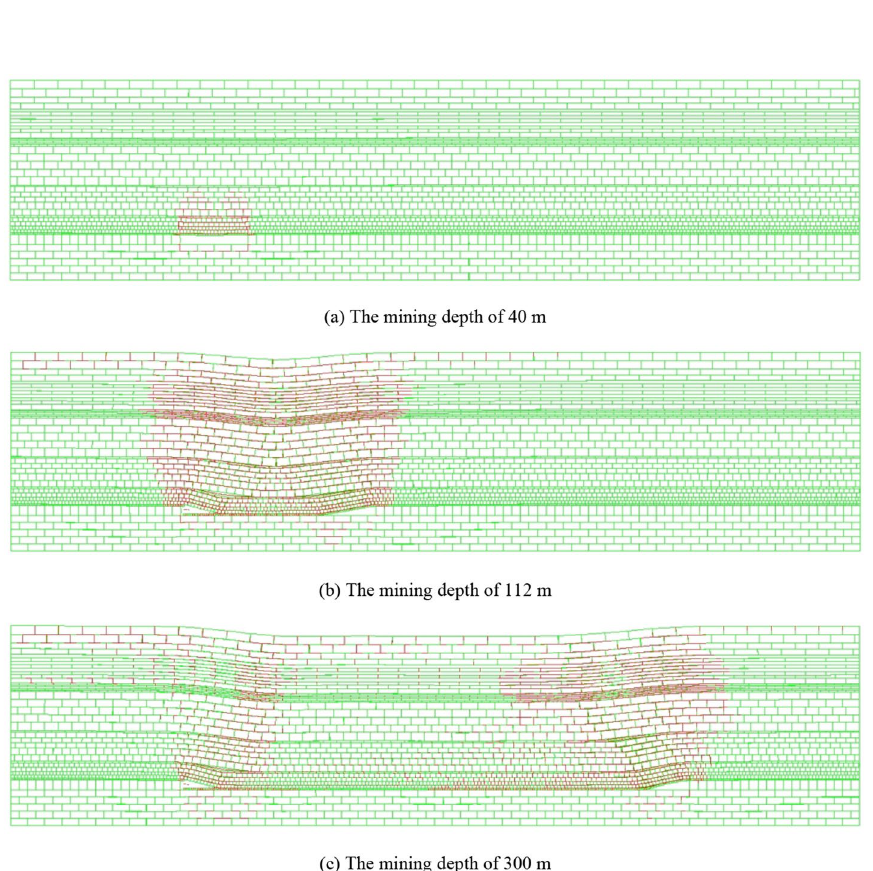
Figure 2. The distribution of overburden fractures (UDEC